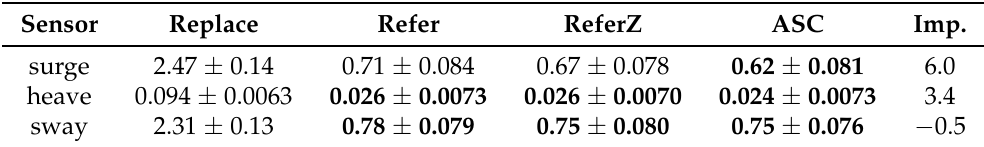
Table 4. Reconstruction errors (RMSE) on UUV data for compound sensor changes. Each entry shows the average reconstruction error and the corresponding standard error. Imp. shows the average improvement (in %) of ASC over the best baseline method. The best performing method(s) (statistically significant up to one standard error) are in bold